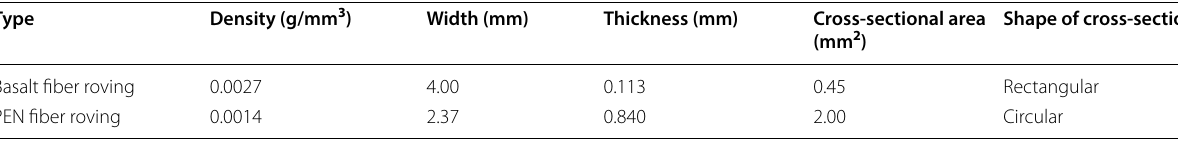
Table 2 Physical properties of BF and PEN fiber.